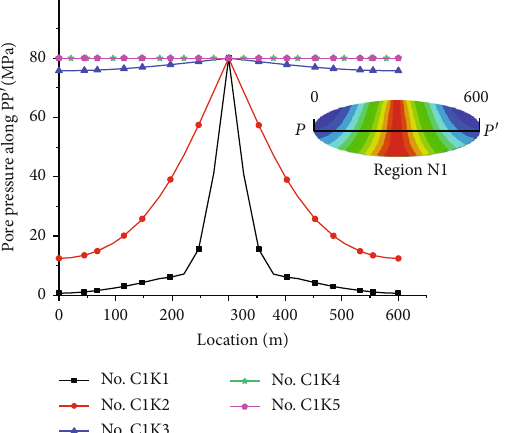
Figure 25: Pore pressure pro fi les along the long axis of region N1 (PP ′ ) according to di ff erent permeability (Nos. C1K1-C1K5).